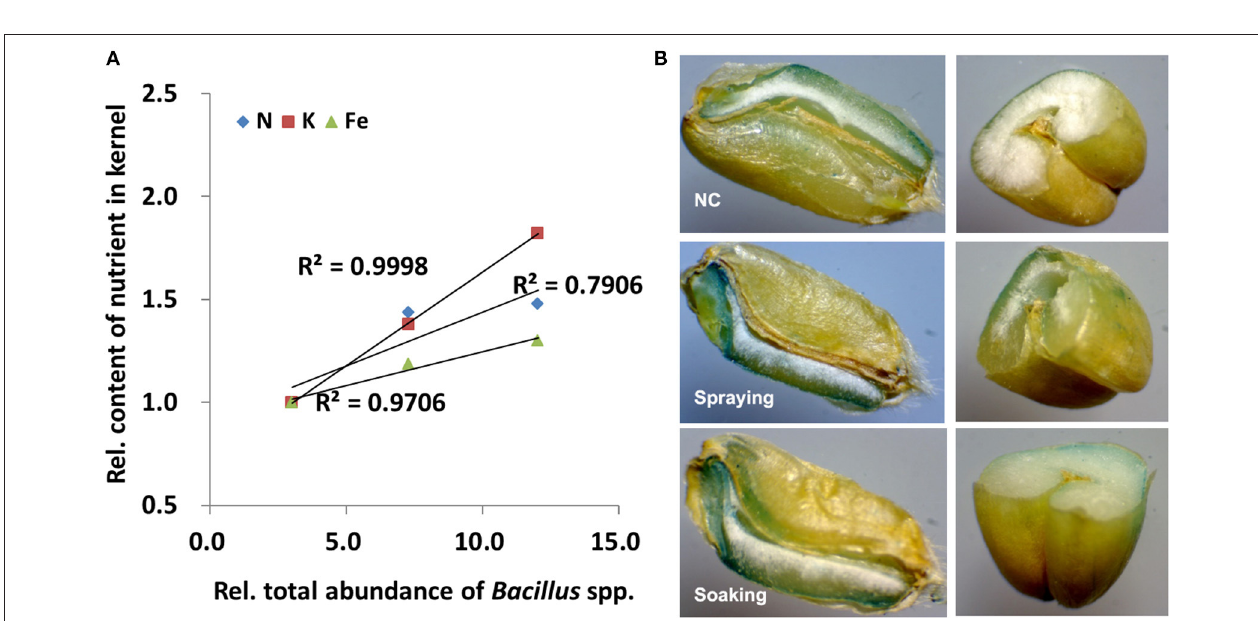
FIGURE 3 | Correlation analysis and iron staining. (A) Linear regression and coefficients of determination ( R 2 ) between the total abundances of Bacillus spp. and content of three nutrients; (B) Perls’ Prussian blue staining of grains. All data were normalized to their respective counterparts in the control group (NC) without inoculation of bacteria. In spraying, soils were sprayed with B. altitudinis WR10 before sowing of wheat; in soaking, wheat seeds were soaked in B. altitudinis WR10 suspension before sowing.